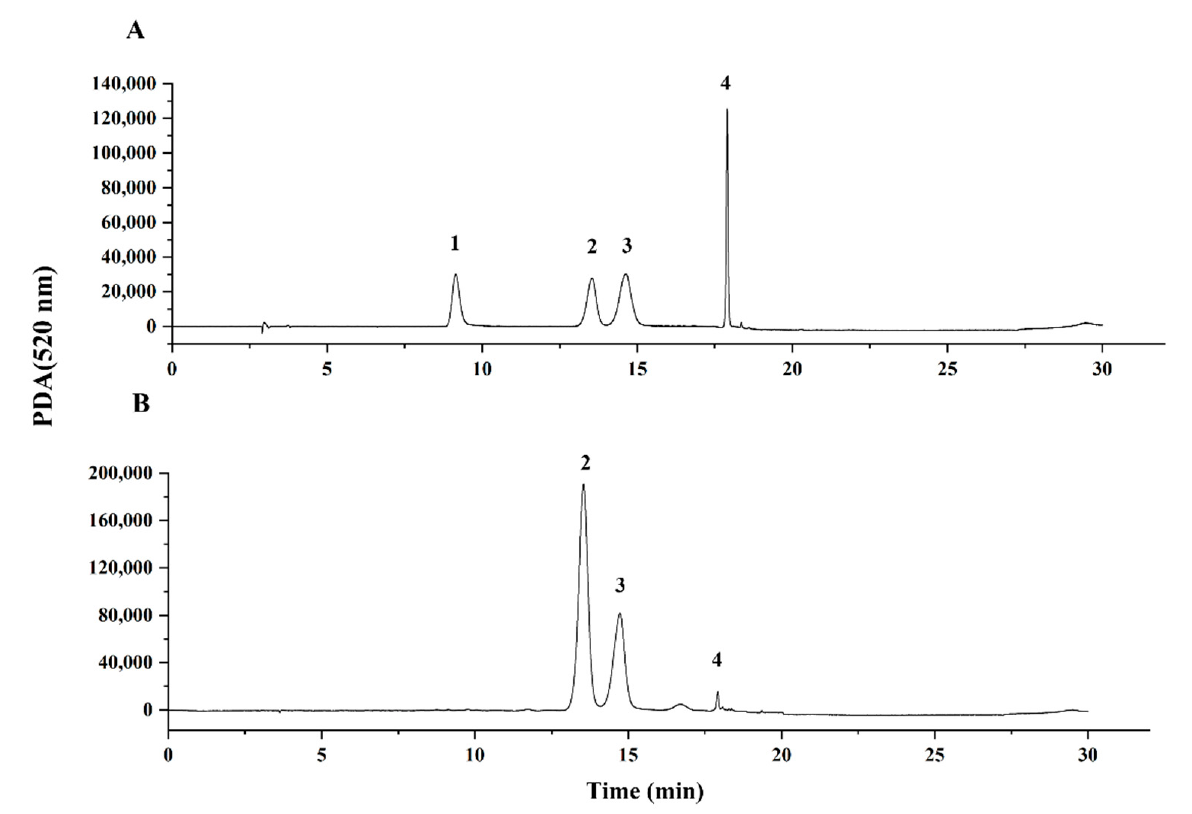
Figure 1. HPLC chromatograms of ( A ) the four standard substances of anthocyanins and ( B ) mulberry fruit extracts (Dechang, ZS) were recorded at 520 nm using a PDA detector. Peak 1, pelargonidin- 3- O -glucoside (P3G); 2, cyanidin-3- O -glucoside (C3G); 3, cyanidin-3- O -rutinoside (C3R); and 4, pelargonidin-3- O -rutinoside